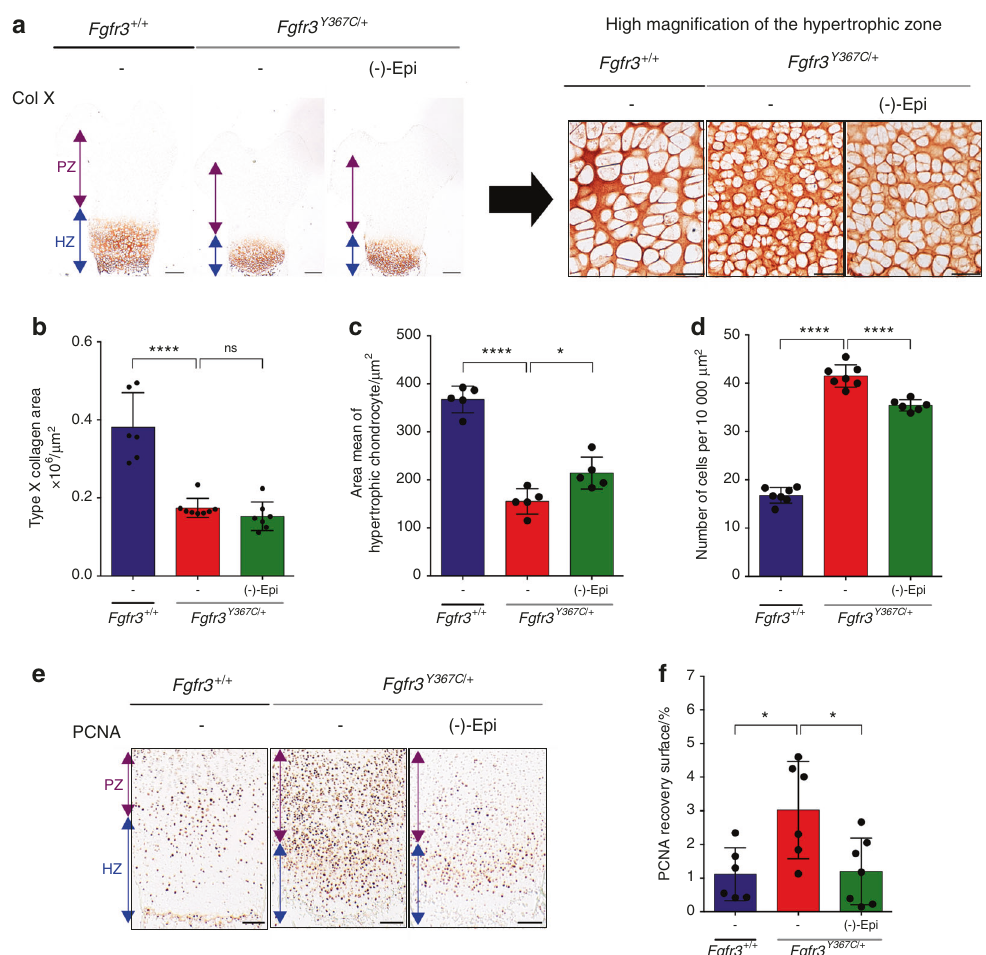
Fig. 4 (-)-Epicatechin modulates hypertrophic and proliferative chondrocytes in ex vivo Fgfr3 Y367C/ + femurs. a Representative images of type X collagen immunostaining of Fgfr3 + / + and Fgfr3 Y367C/ + embryonic distal femurs (scale bars: 200 μ m). High-magni fi cation inset of a representative image of type X collagen immunostaining in the hypertrophic distal zone of Fgfr3 + / + and Fgfr3 Y367C/ + distal femurs (scale